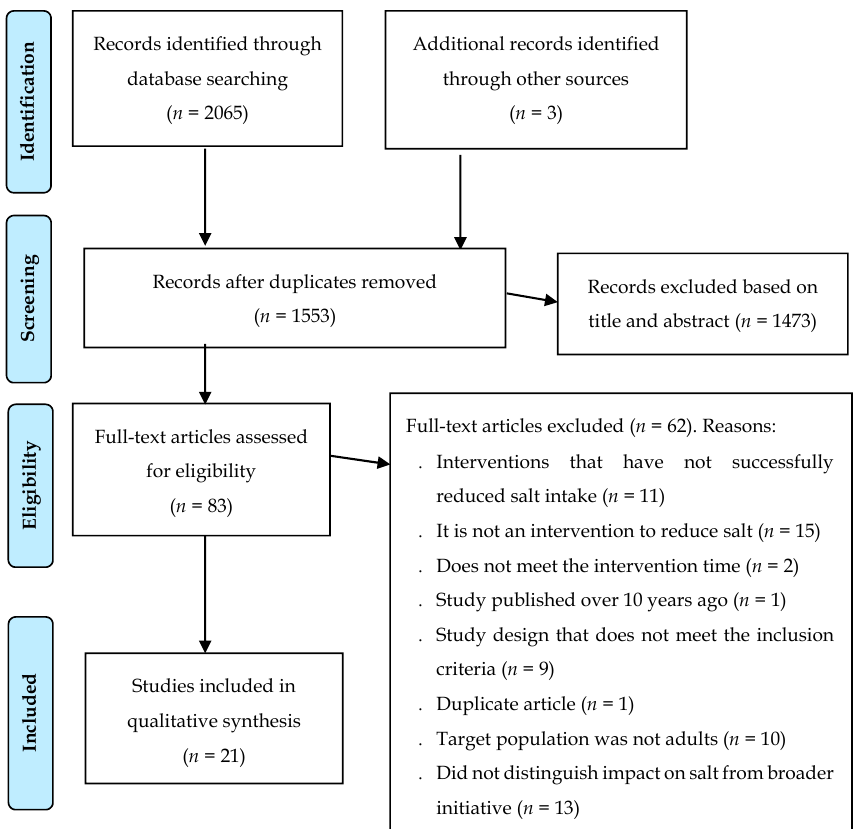
Figure 1. PRISMA flow chart of included studies.